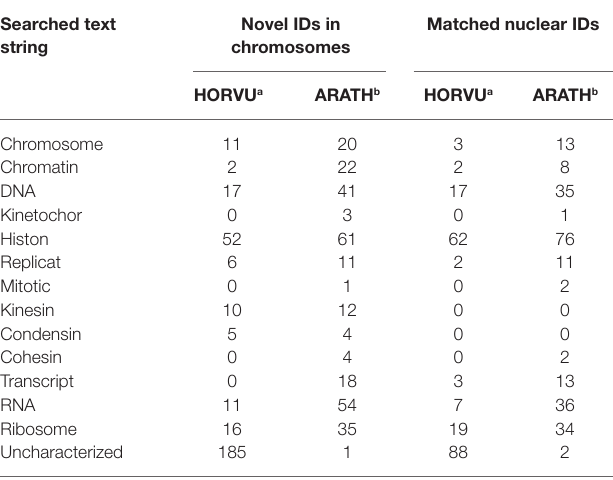
The text strings provided in the first column were applied as “keywords” for searching in the names of barley or homologous Arabidopsis proteins (see Supplementary Table S5 ). Only 311 out of the 837 proteins matched the original dataset of the barley nuclear protein database UNcleProt (Blavet et al., 2017). The others were thus considered novel IDs. a HORVU, Hordeum